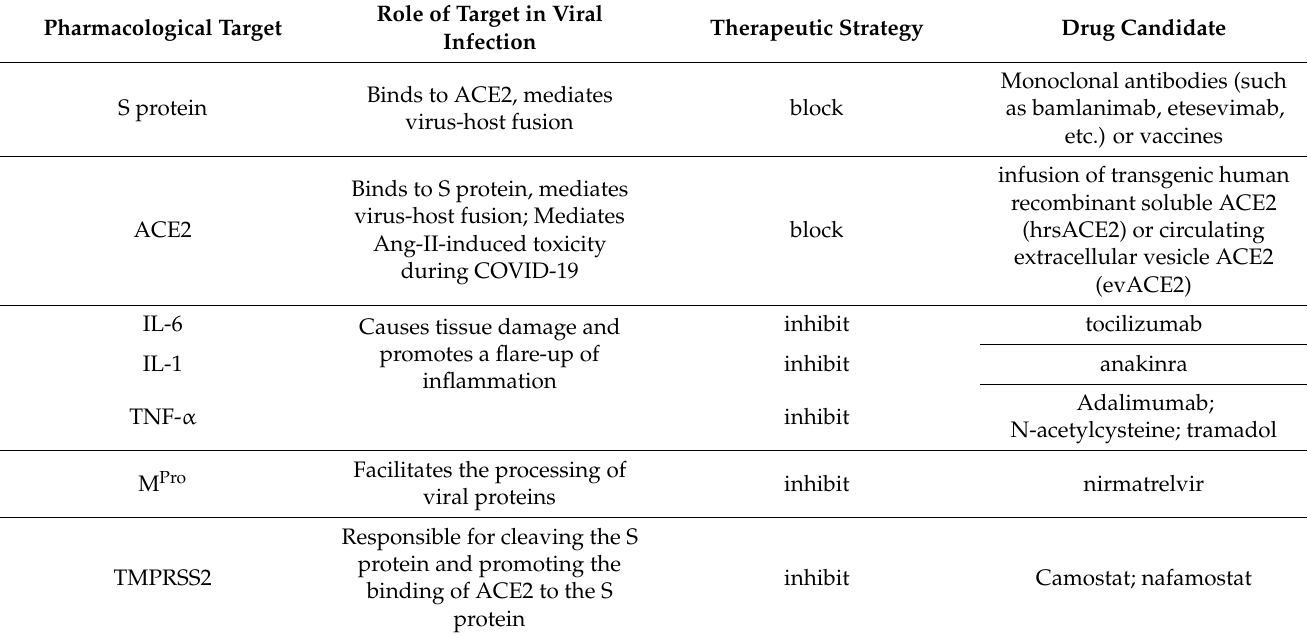
Table 3. Potential molecular therapeutic